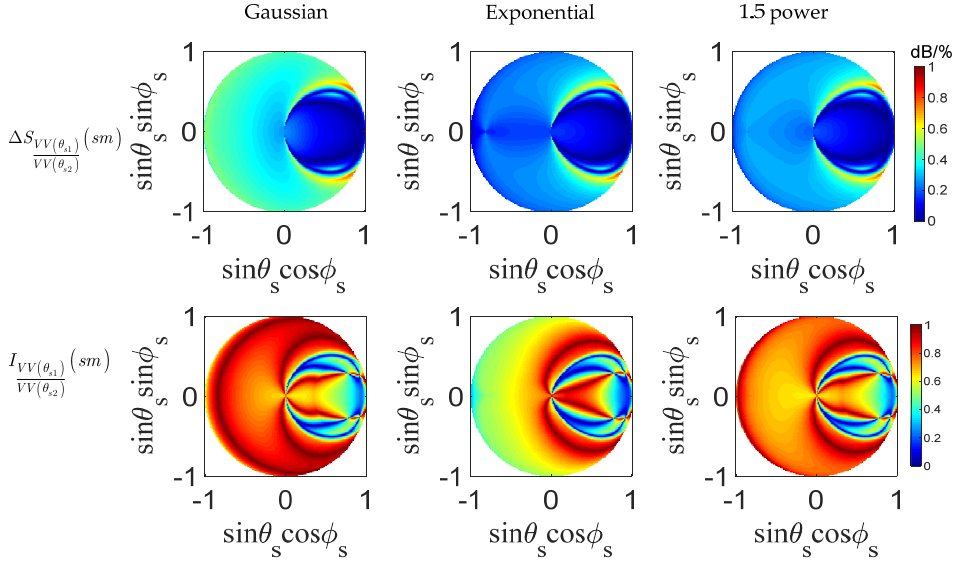
Figure 12. Patterns of sensitivity 𝜎 (cid:3023)(cid:3023)(cid:2868) (𝜃 (cid:3046)(cid:2869) )/𝜎 (cid:3023)(cid:3023)(cid:2868) (𝜃 (cid:3046)(cid:2870) ) to soil moisture between 40% and 10% (first line), and the quality index (second line).